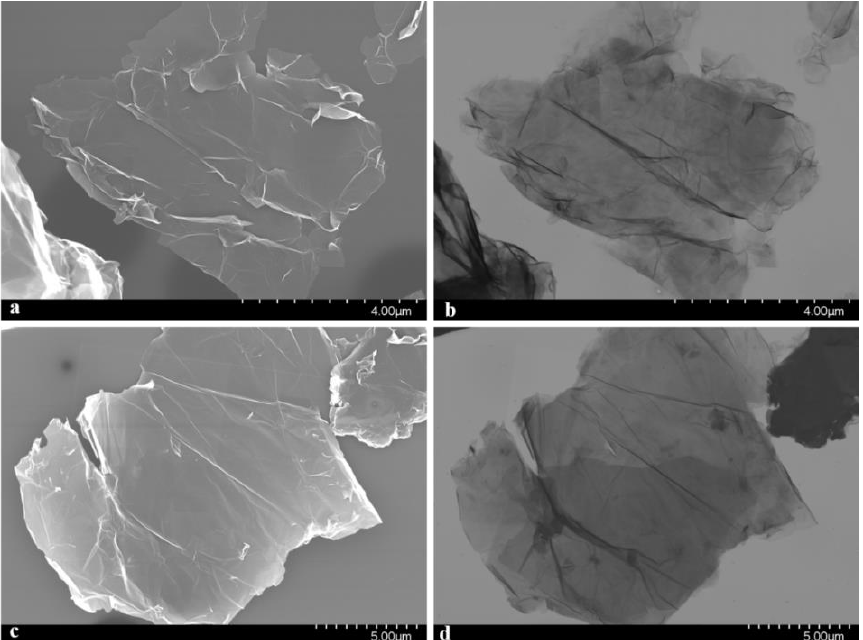
Figure 2. SEM/TEM micrographs showing the morphological aspects of isolated graphene flakes: NSGr-120 ( a , b ); NSGr-200 ( c , d ) .